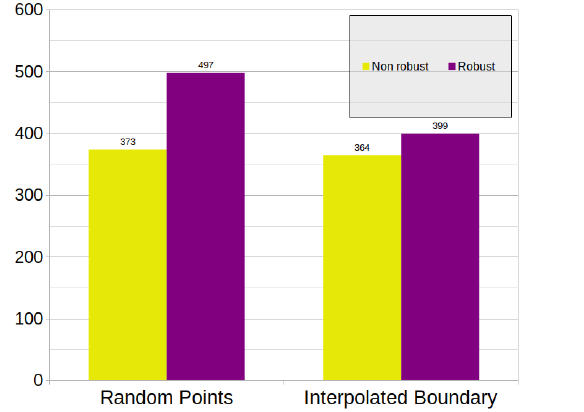
Figure 4. Timings in ms for testing whether a point is in continental Russia polygon from (Kelso and Patterson,